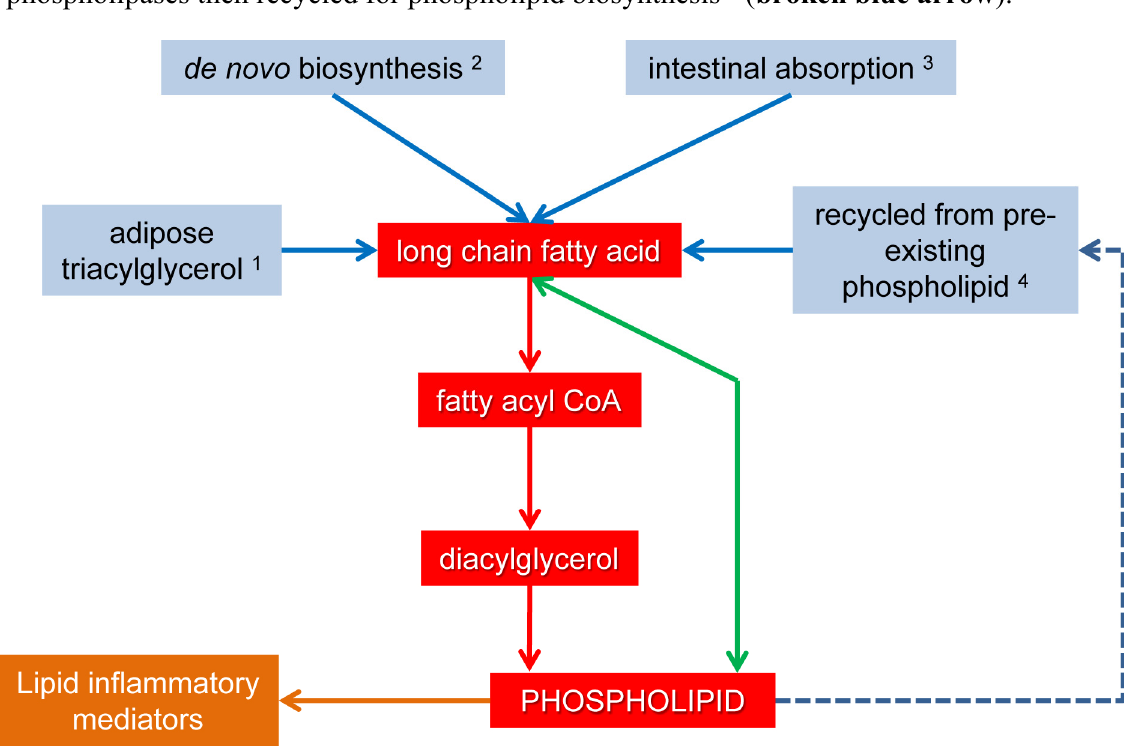
Figure 3. The utilization of long chain fatty acids for de novo phospholipid biosynthesis (Kennedy pathway, red arrows and boxes ), post-synthetic modification of phospholipids by reacylation (Lands’ cycle, green arrow ), and the metabolism of phospholipids to oxidized lipid mediators of inflammation ( orange arrow and box ) in critical cells during inflammatory responses, such as vascular endothelial cells and mononuclear